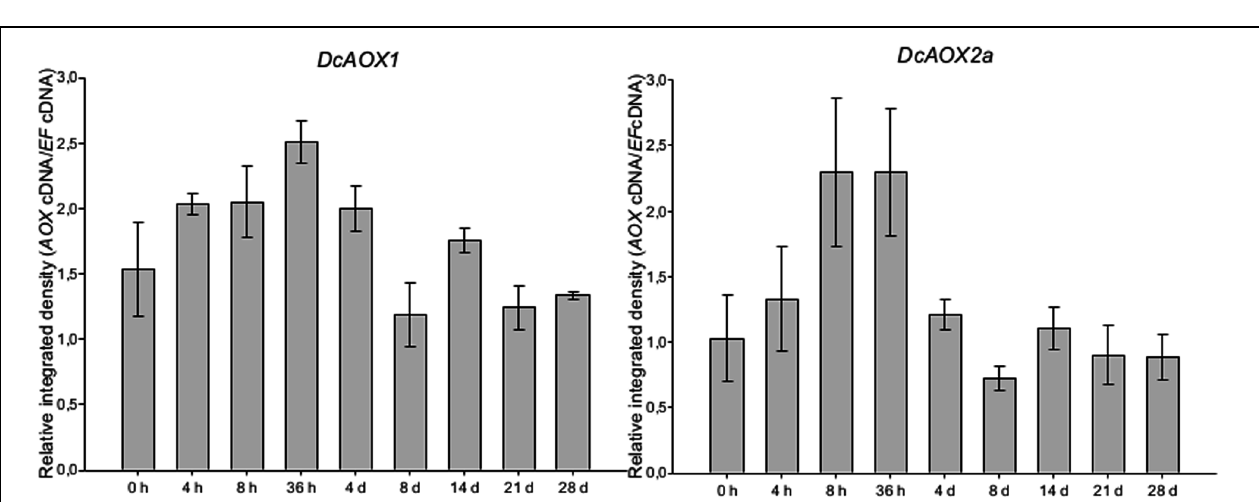
FIGURE 2 | Transcript levels of DcAOX1 and DcAOX2a in primary cultures from secondary phloem of carrot roots. Samples were collected at 0 h, 4 h, 8 h, 36 h, 4, 8, 14, 21, and 28 days post in vitro inoculation. Cultures were maintained at 21 ◦ C. Transcript levels were analyzed by RT-sqPCR using DcEF1 α as reference gene. Normalization of the quantity of DcAOX transcripts was performed through the ratio of integrated densities DcAOX cDNA and DcEF1 α cDNA bands. Data are the mean values ± SE of four individual